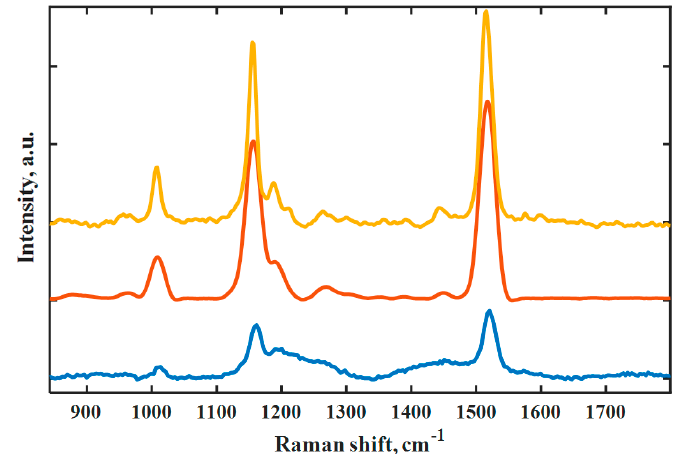
Figure 2. Comparison of the Raman spectra of a hot pepper using instruments with different laser wavelengths. Spectra of mobile spectrometer with laser wavelength at 638 nm, 1 acquisition at 1 spot (blue), handheld spectrometer at 785 nm, ROS with averaging of 1 acquisition each at 10 spots (orange) and benchtop spectrometer at 1064 nm, 64 acquisitions (yellow).